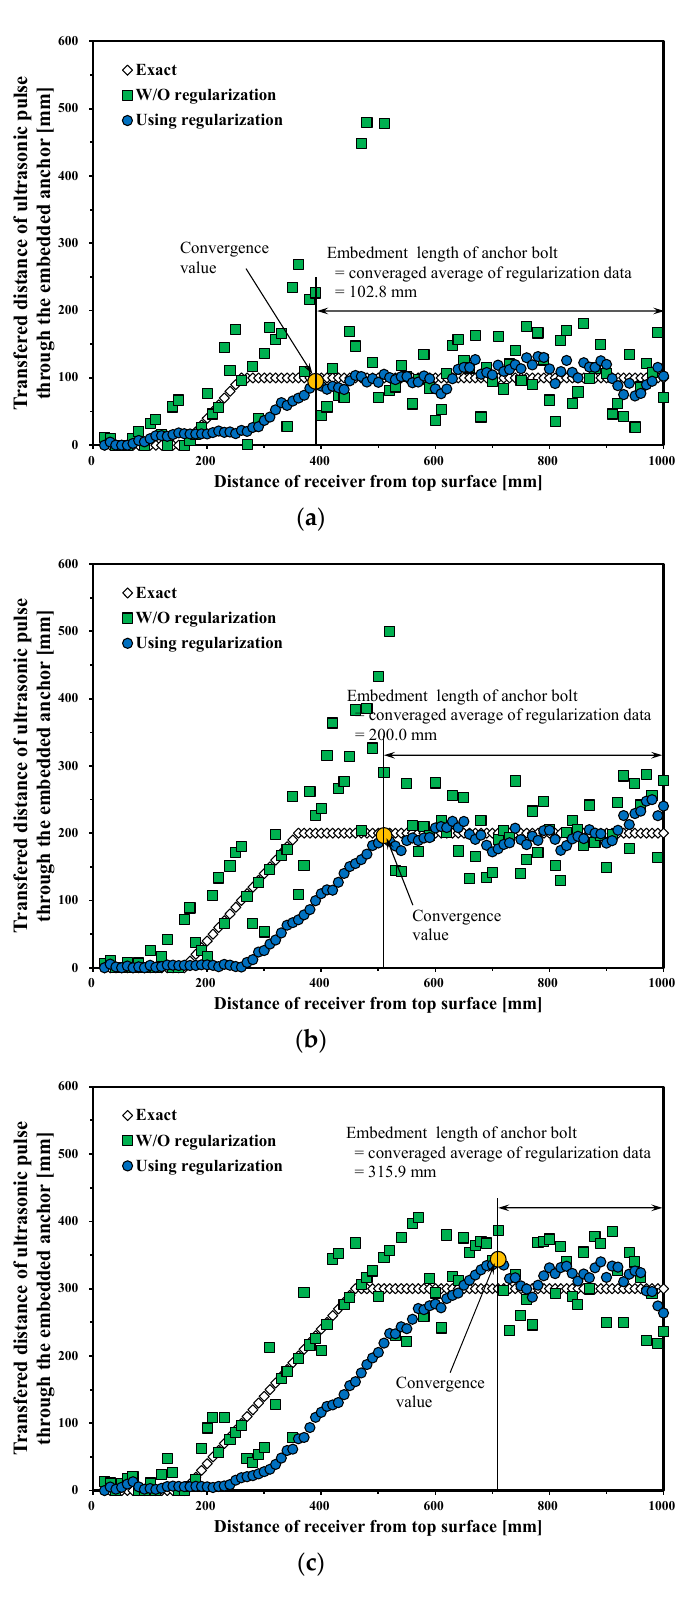
Figure 6. Results of the numerical verification for white noise and regularization in specimens with a cover thickness of 200 mm: ( a ) E100C200; ( b ) E200C200; ( c ) E300C200. Table 2. Estimated embedment depth of the anchor bolt in numerical verification.